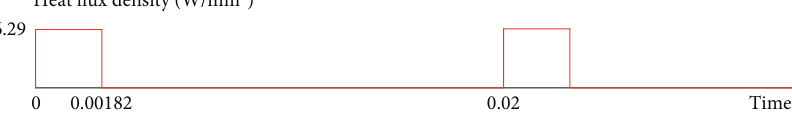
Figure 15: The loading process of the first load step of the driving gear.